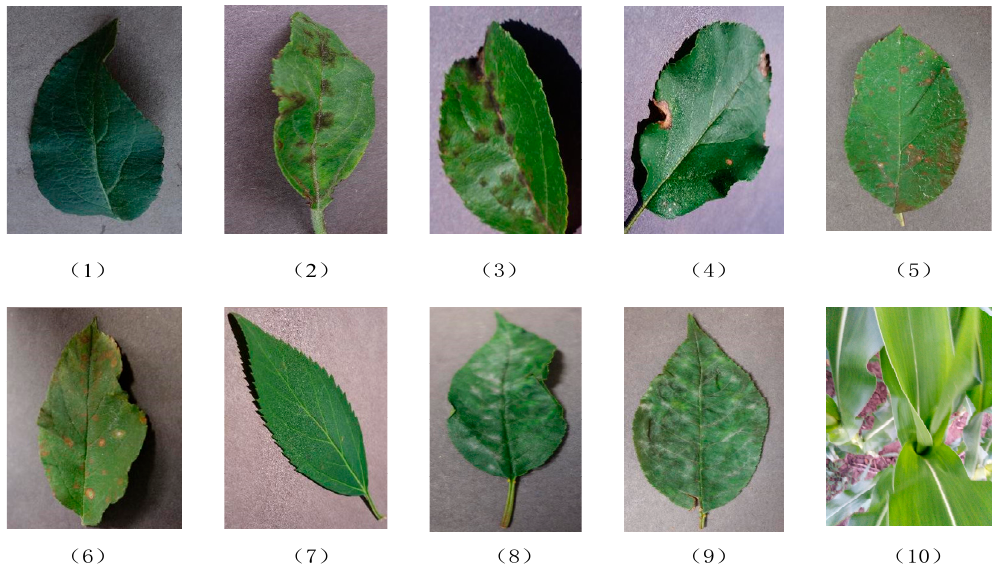
Figure 1. Sample images of 10 leaf diseases. ( 1 ) Apple healthy (AH); ( 2 ) Apple Scab general (ASG); ( 3 )